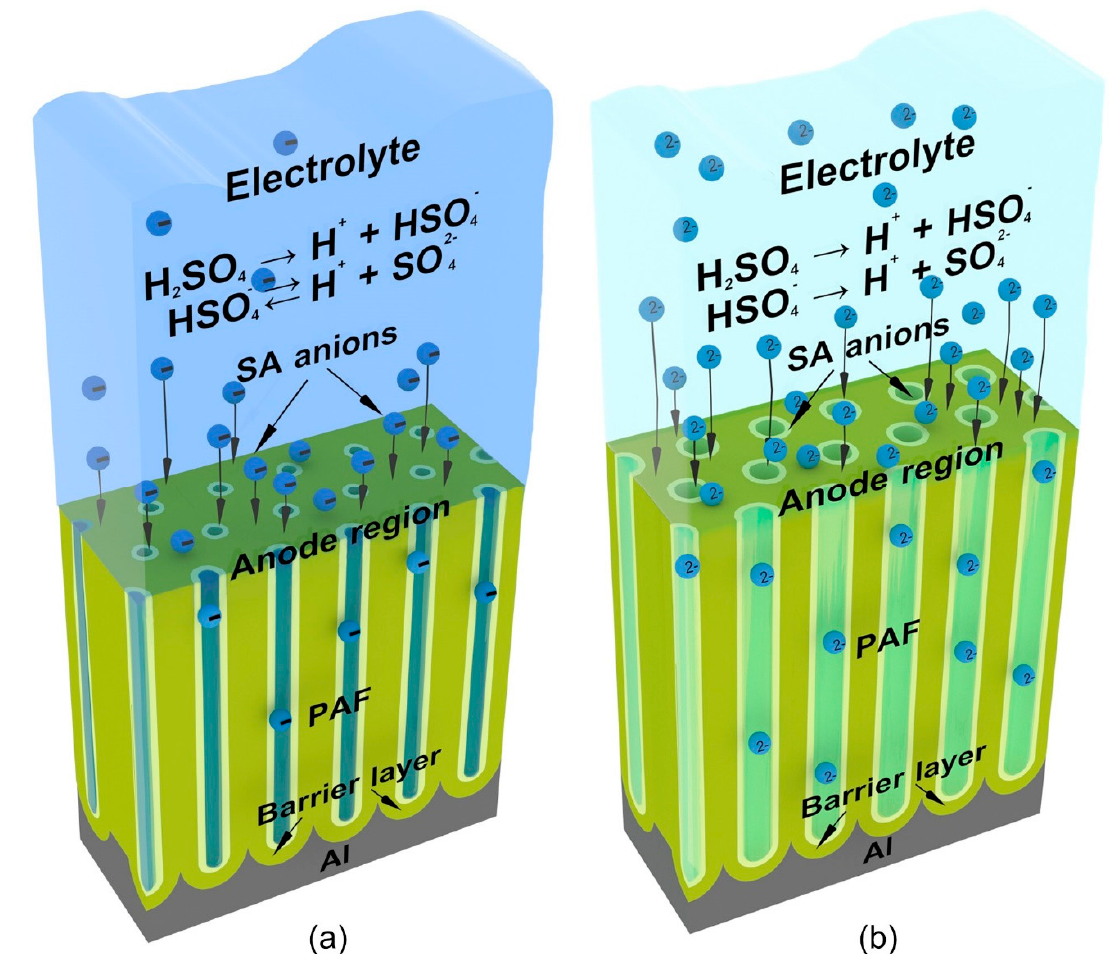
Figure 5. Schematic 3-D views of the formation process of porous alumina films in sulfuric acid solutions with concentration increased ( a ) and reduced ( b ) with respect to the starting